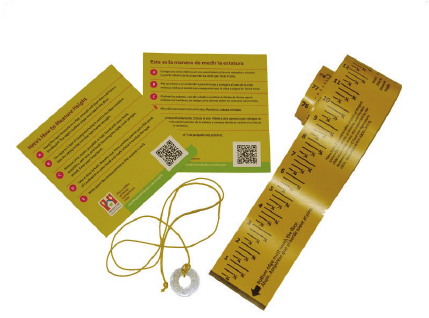
Figure 2: Height measurement kit. Video: http://healthyhomestyles